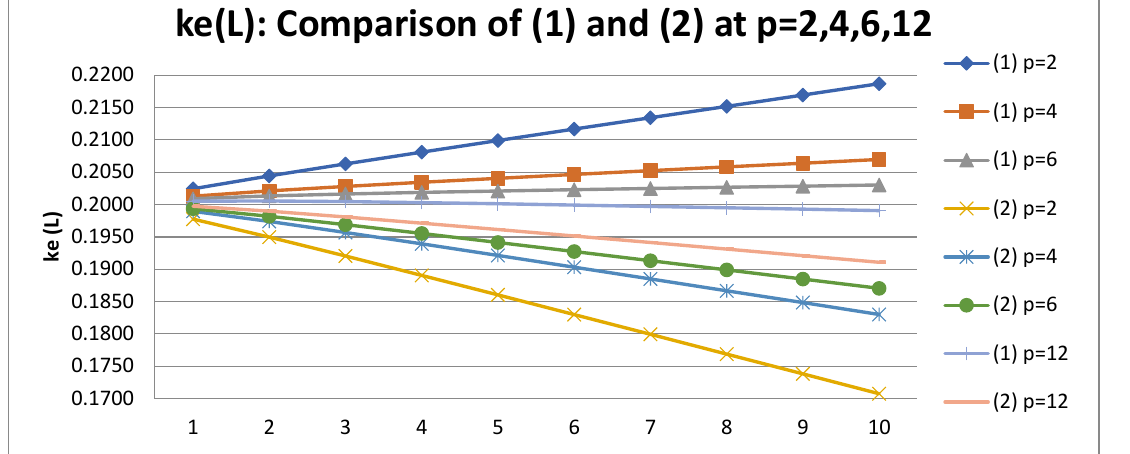
Figure 12. The comparison of the dependence of the equity cost ( ke ) on the leverage level ( L ) of a six-year-old company for profit tax payments that were (1) made at the end of the financial period and (2) made at the beginning of the financial period (i.e., advance payments) with frequencies of p = 2, 4, 6 and 12.